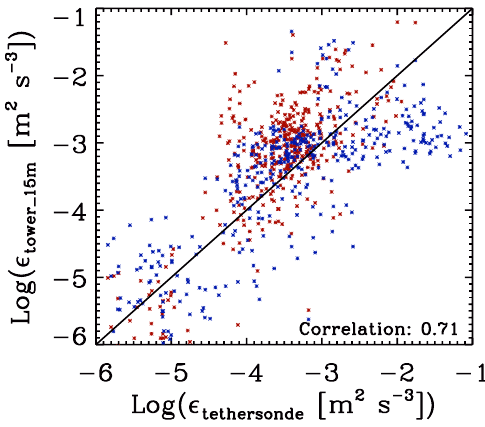
Fig. 4. Point-to-point comparisons of dissipation rate derived from the tethersonde and meteorological tower measurements at ASCOS. The tower measurements are made at 15 (blue) and 30m (red). The one-to-one line is included.